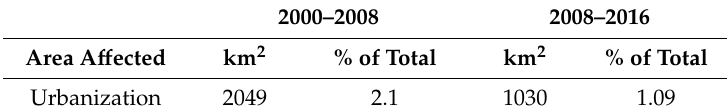
Table 8. Increase of the built surfaces during 2000–2016 in Vietnam [124].